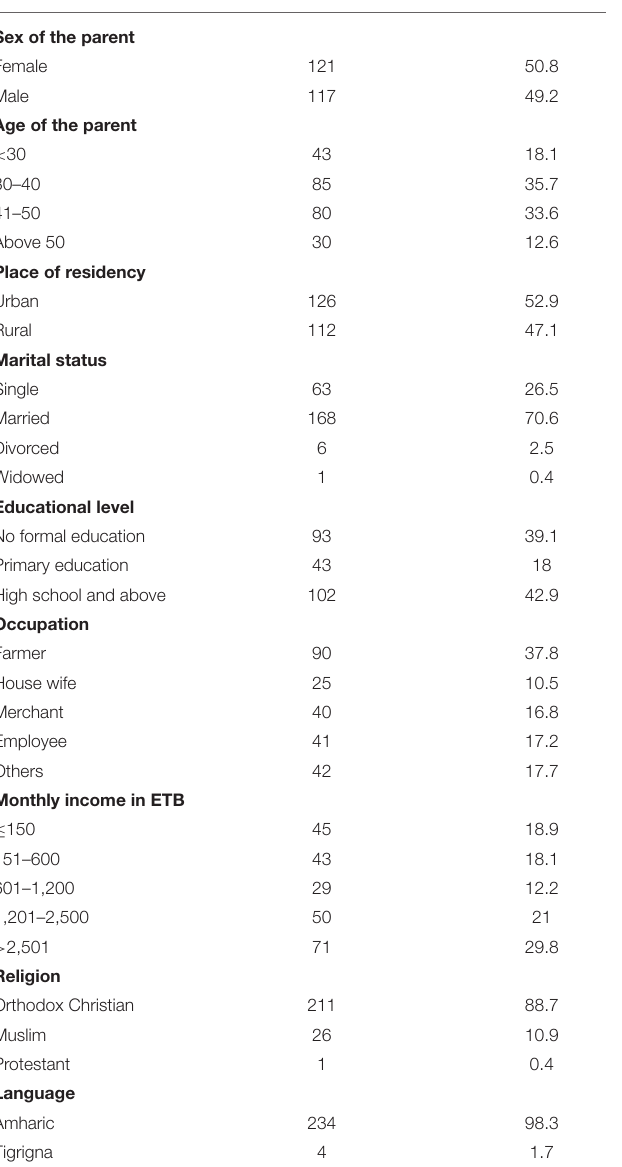
TABLE 1 | Socio-demographic characteristics of parents related with parental satisfaction toward their child’s anesthesia service, N = 238, 2021. Characteristics